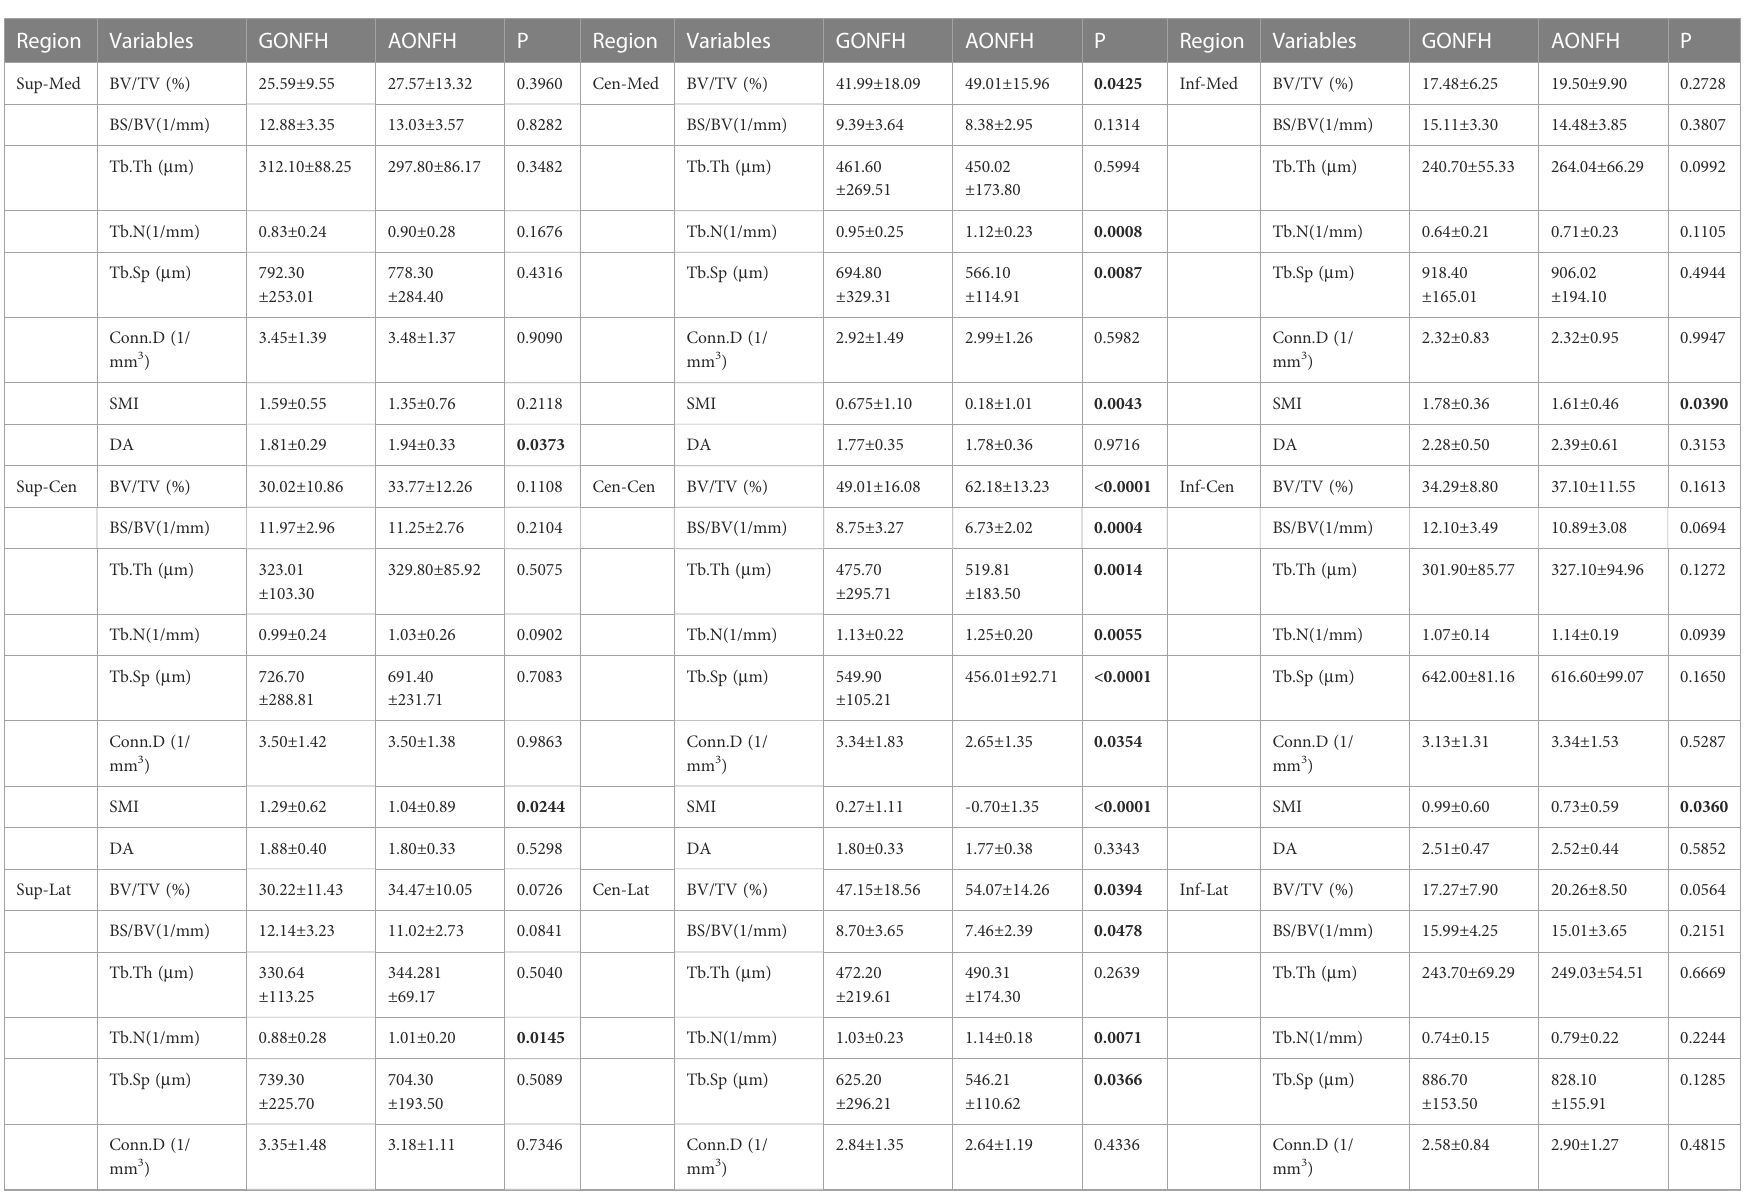
TABLE 2 Comparison of microarchitecture parameters in different regions between GONFH and AONFH.